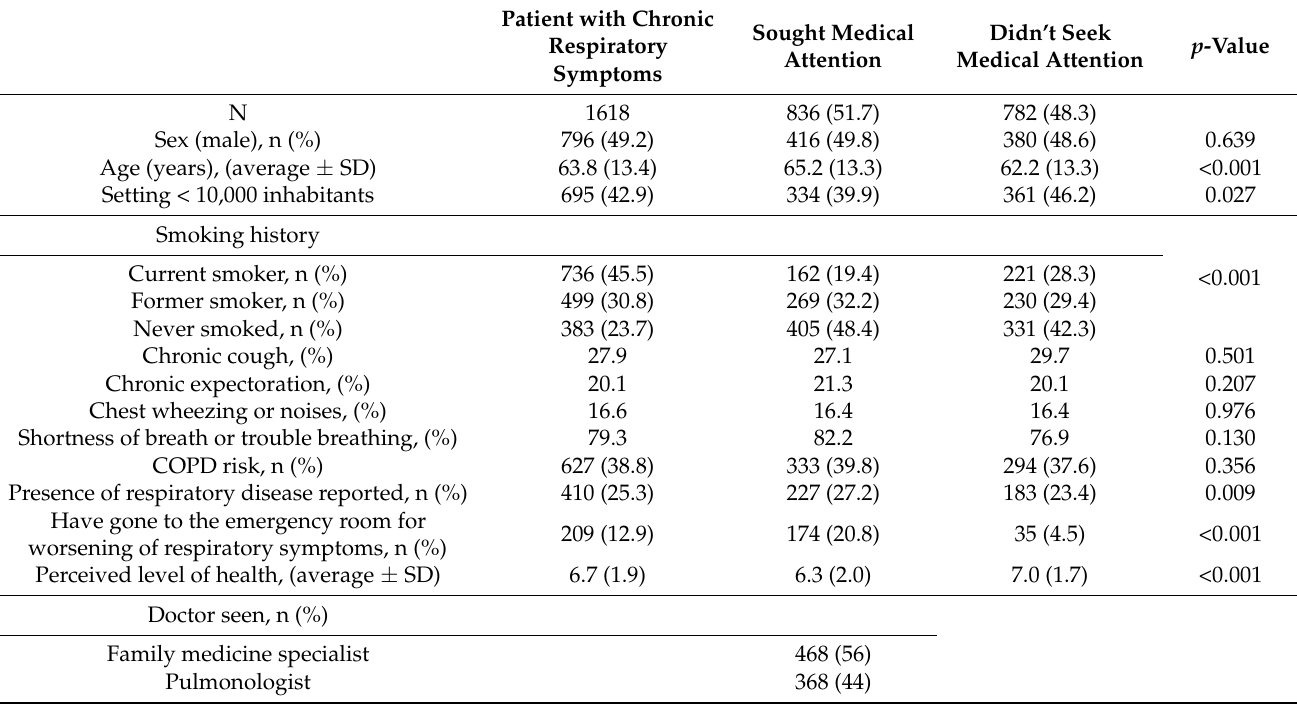
Table 2. Characteristics of patients with respiratory symptoms according to medical attention sought.